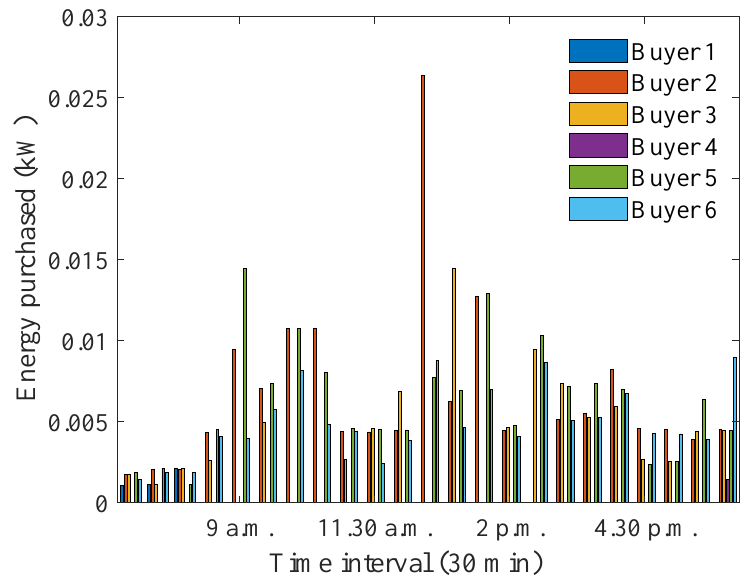
Figure 4. Optimum energy purchased during winter